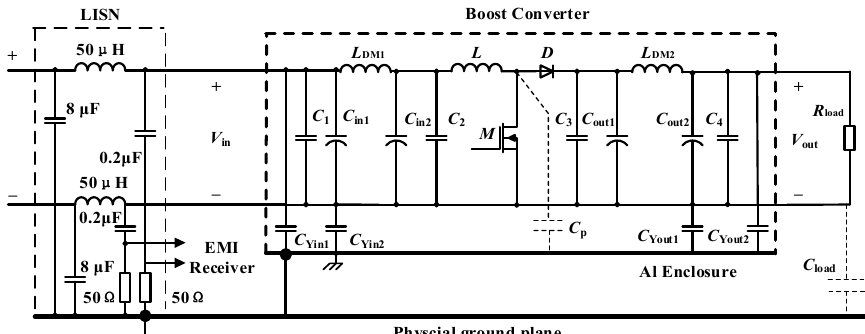
Figure 1. Boost converter and its conducted emission test layout.